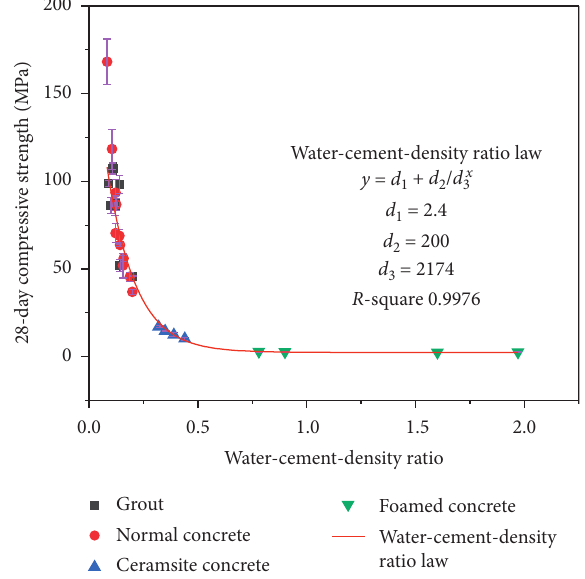
Figure 11: Simulation of water-cement-density ratio law for all cement-based materials.